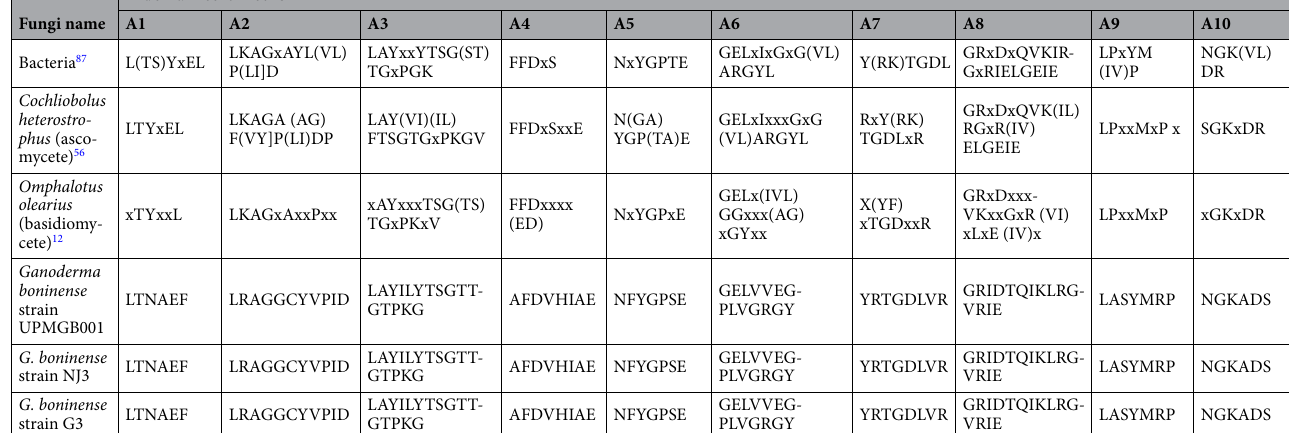
Table 1. Conserved A domain motifs of NRPS protein sequences in bacteria, ascomycetes and basidiomycetes 12 compared with G.